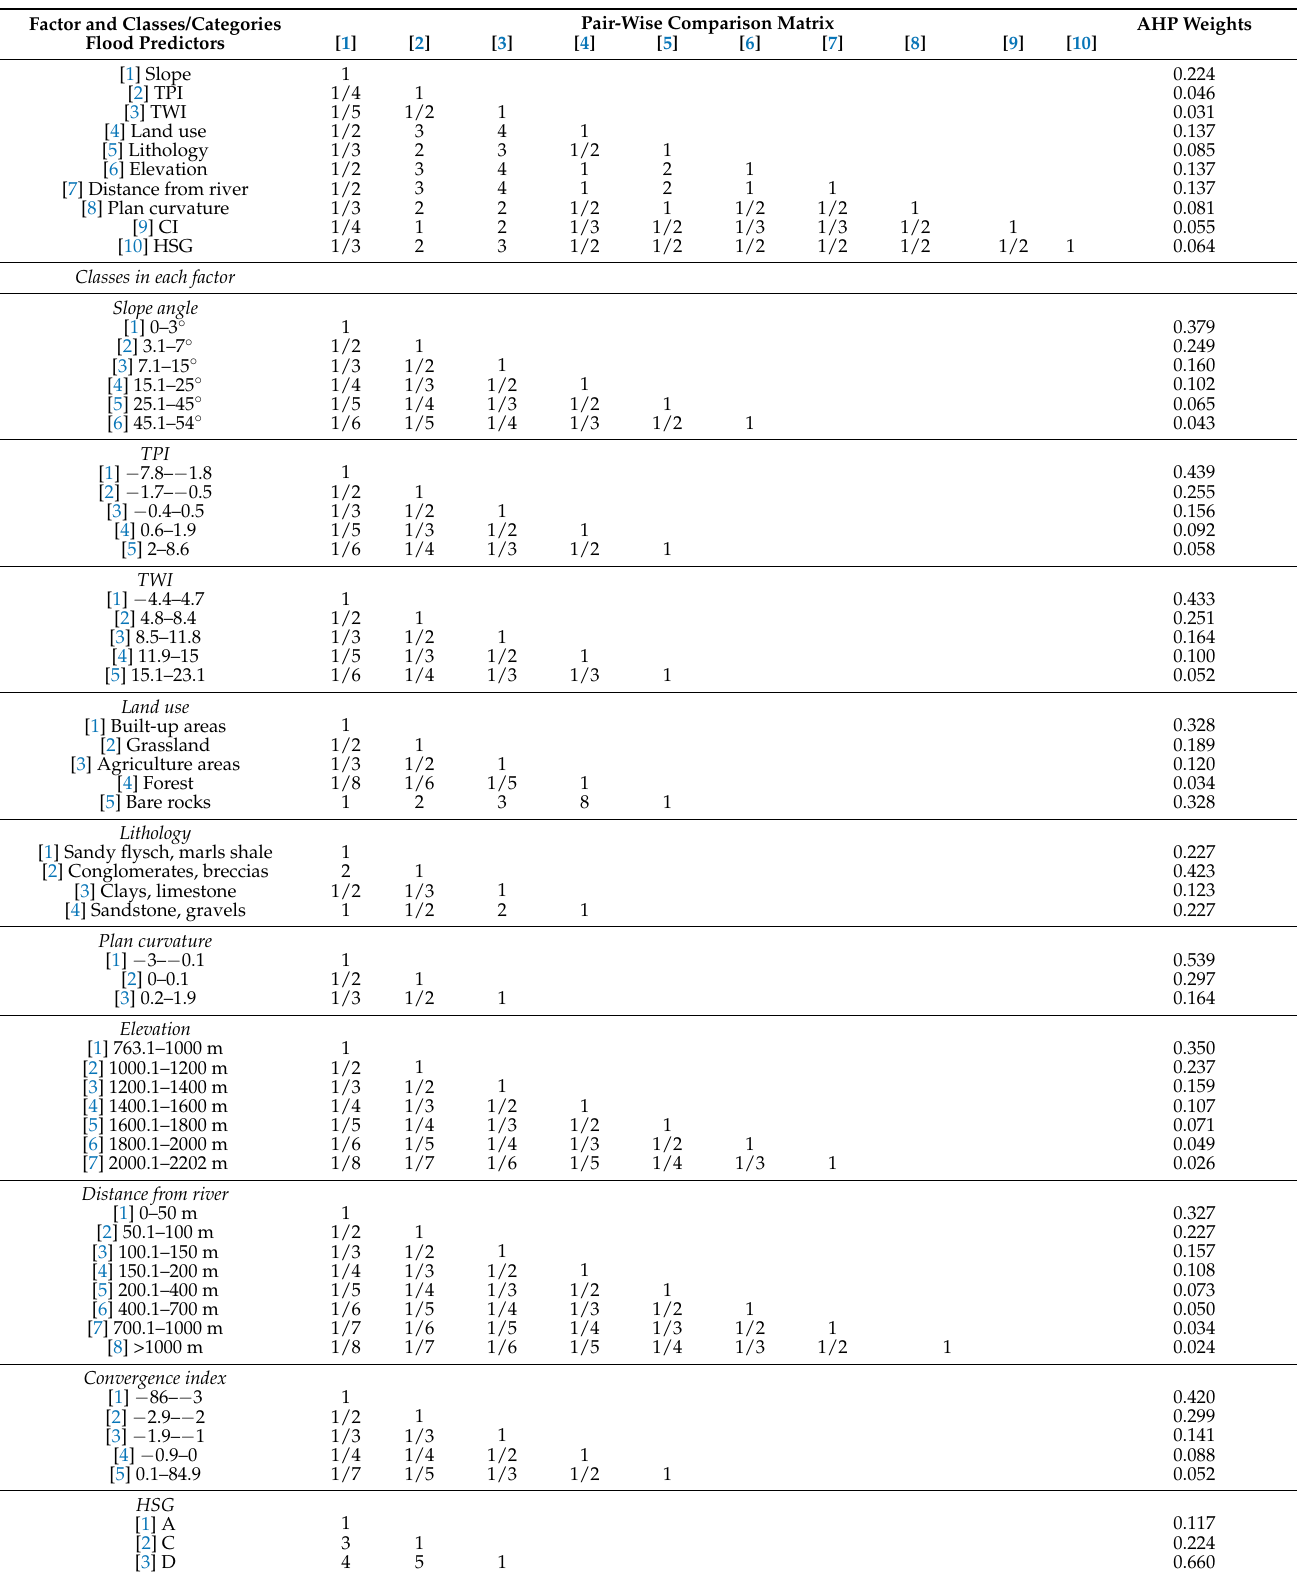
Table 4. Pair-wise comparison matrix and normalized weights for each factor and